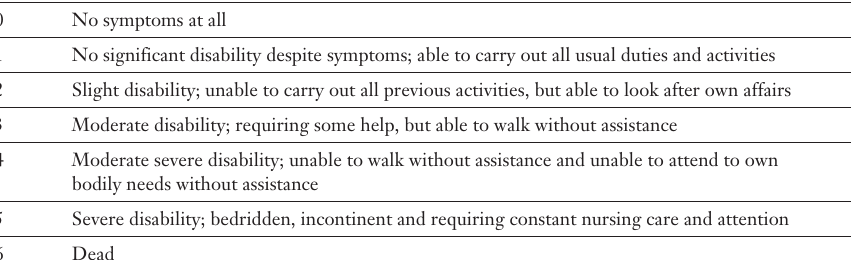
Barthel Index [17, 18].